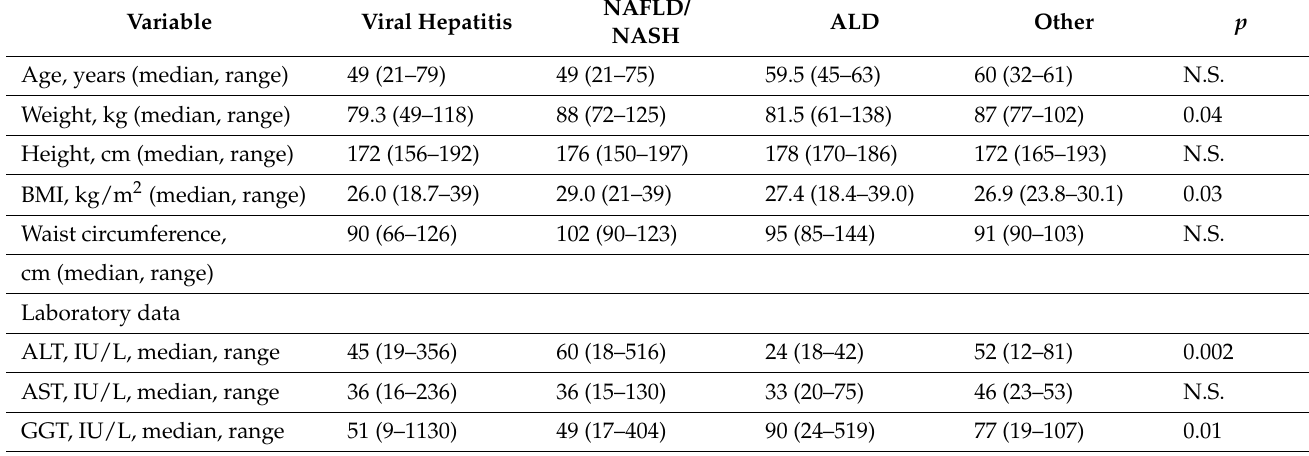
Table 2. Baseline characteristics of the cohort according to liver disease